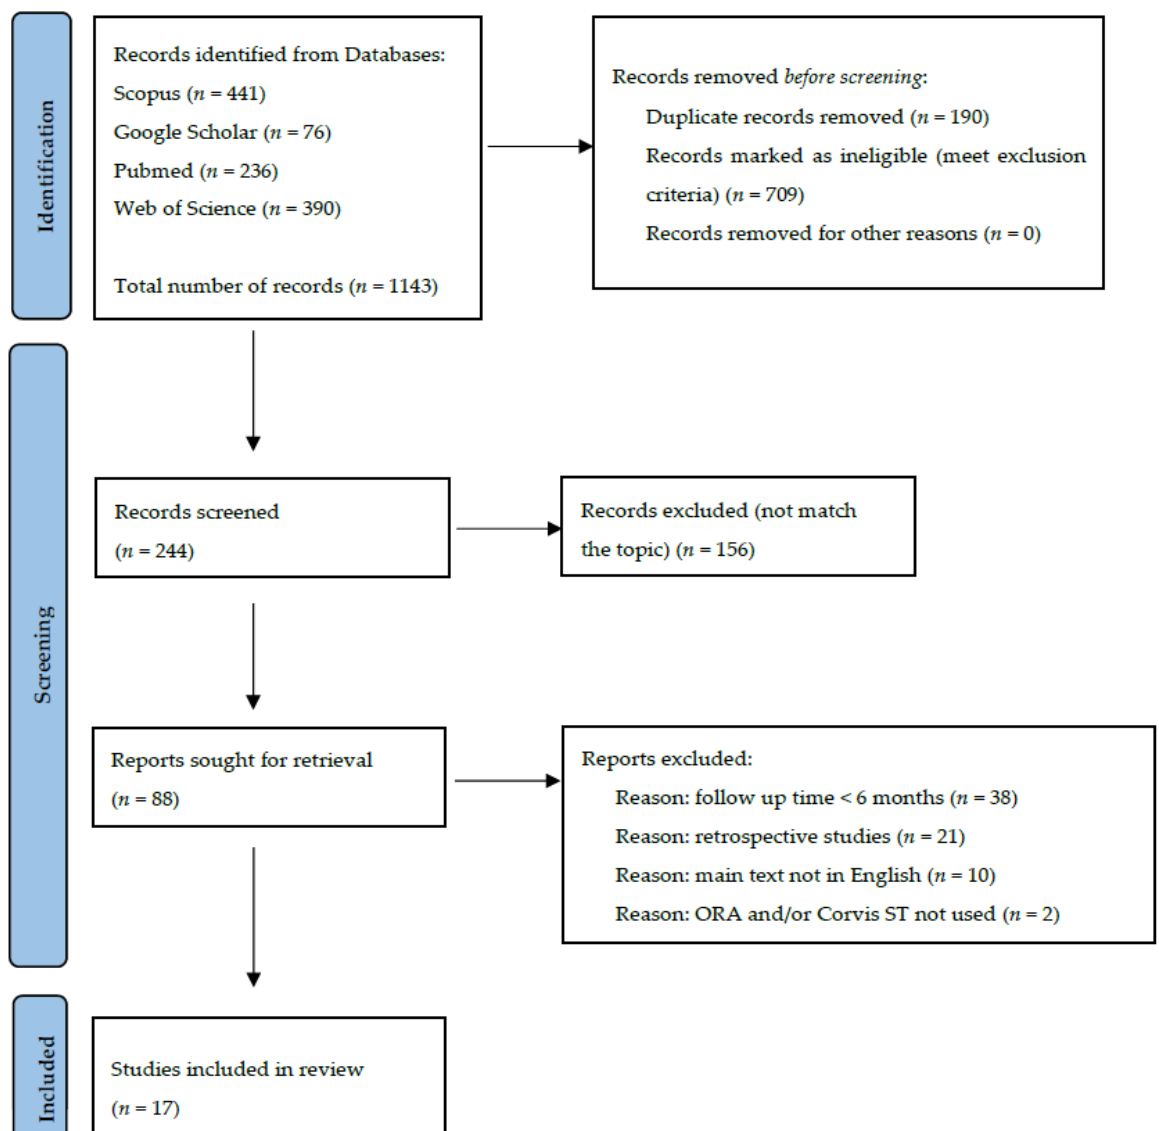
Figure 1. Prisma 2020 flow diagram for Identification of studies via databases.